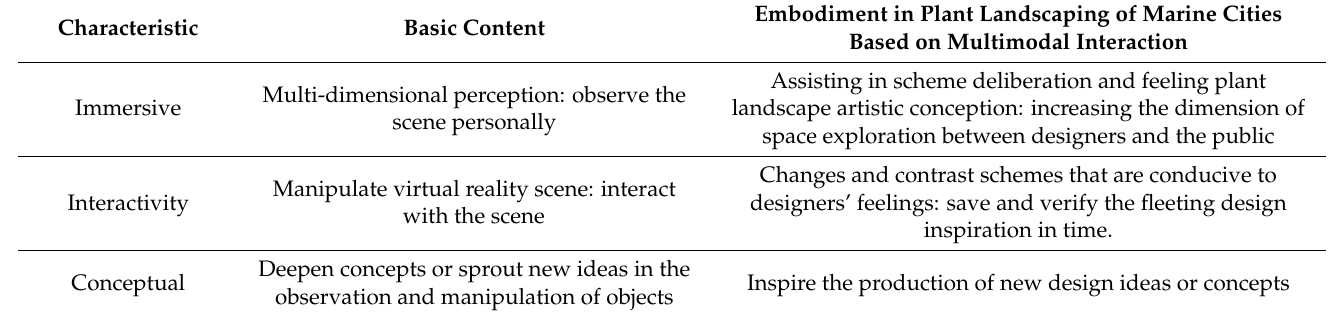
Table 6. The embodiment of multimodal interaction characteristics in plant landscape design of marine